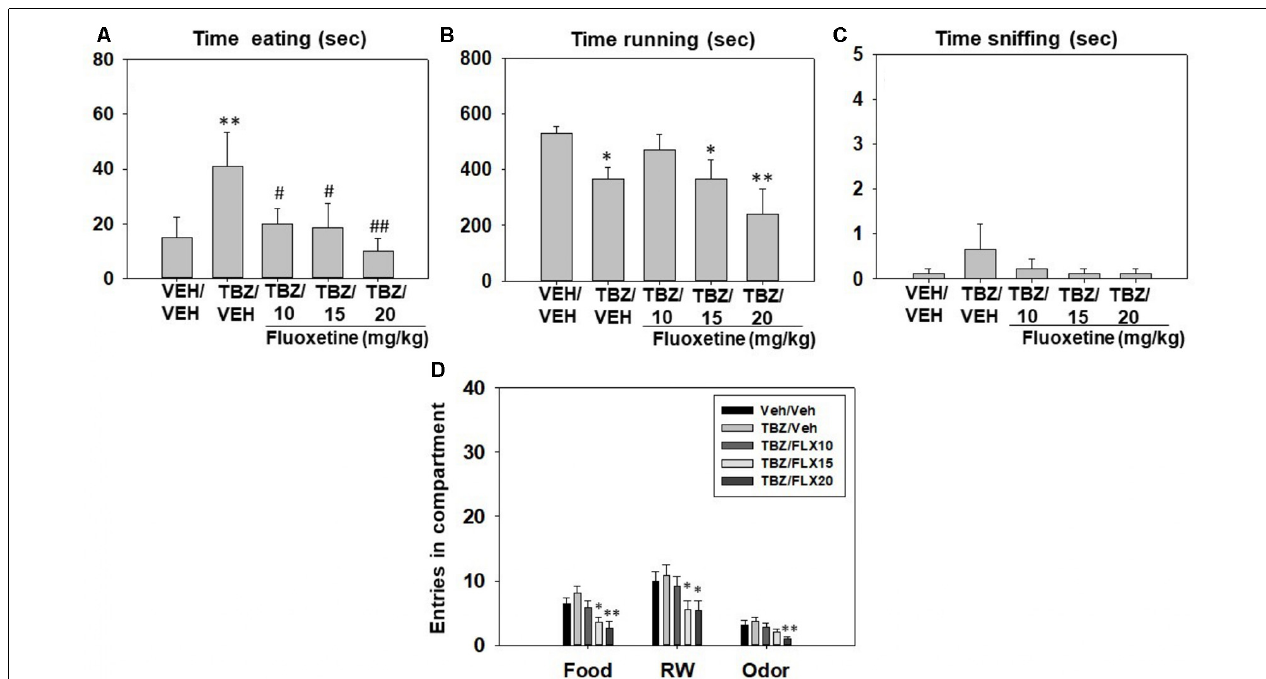
FIGURE 5 | Effect of TBZ (Vehicle or 8 mg/kg) plus fluoxetine (Vehicle, 10, 15, and 20 mg/kg) combination on time eating (A) , time running (B) , time sniffing (C) , entries into compartments (D) , and in the T-maze task assessed during 15 min. Repeated measures ANOVA was used to analyze each variable. Bars represent